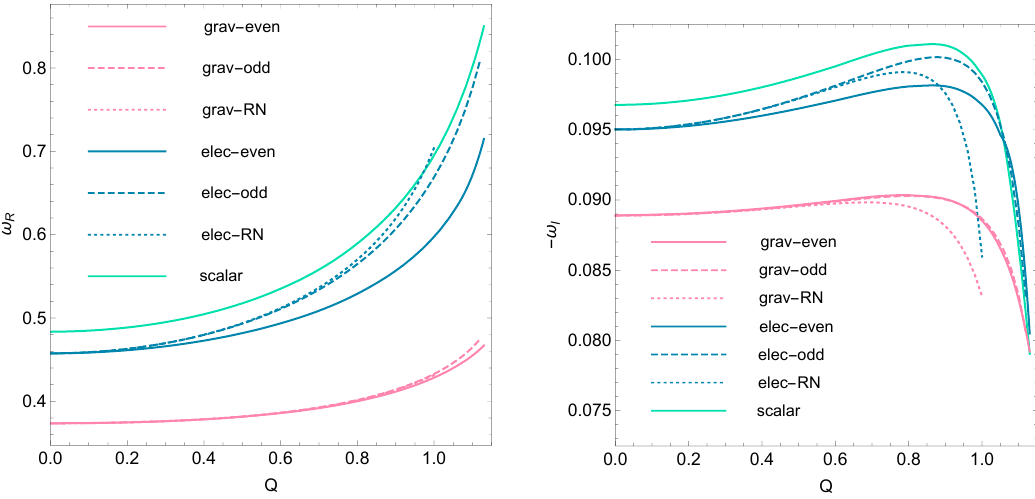
Figure 2 . Fundamental mode (lowest QNMs), for ‘ = 2 and a = 0 . 5 , as a function of the charge Q , in units M = 1 . In pink, we have the modes associated to the gravitational sector, which reduce to the Regge-Wheeler and Zerilli potentials. In blue, the QNM associated to the electromagnetic sector and finally in blue the mode associated to the scalar field. These perturbations are compared to the Reissner-Nordstrom black hole in dotted line. The QNM have been calculated with a step size of 0 . 0025 for the